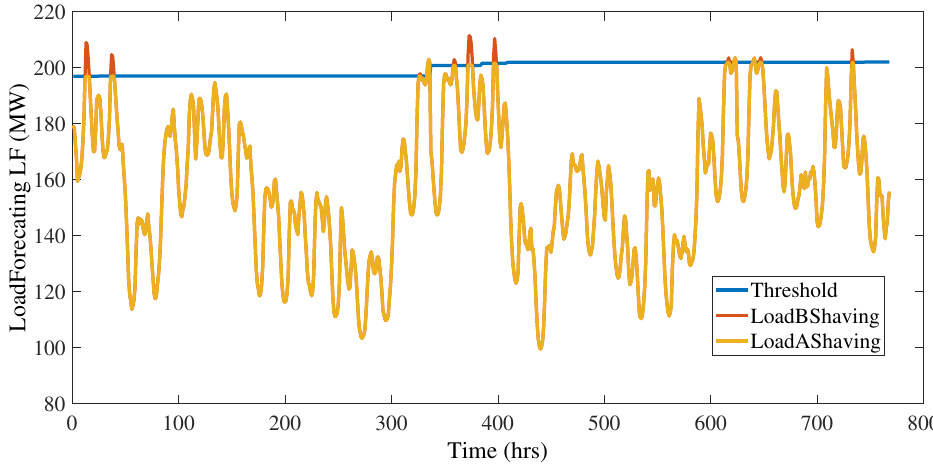
Figure 7. Billing cycle for February